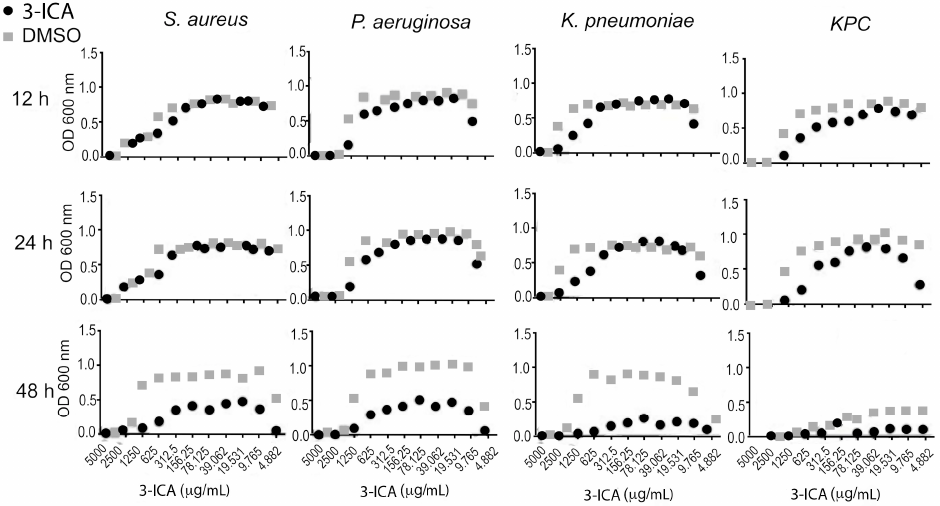
Figure 1. 3-ICA antimicrobial activity in vitro. Bacteria are inoculated into a liquid growth medium in 96-well microtiter plate format in the presence of di ff erent concentrations of 3-ICA to determine the minimum inhibitory concentration (unpublished data, see Supplementary Materials).